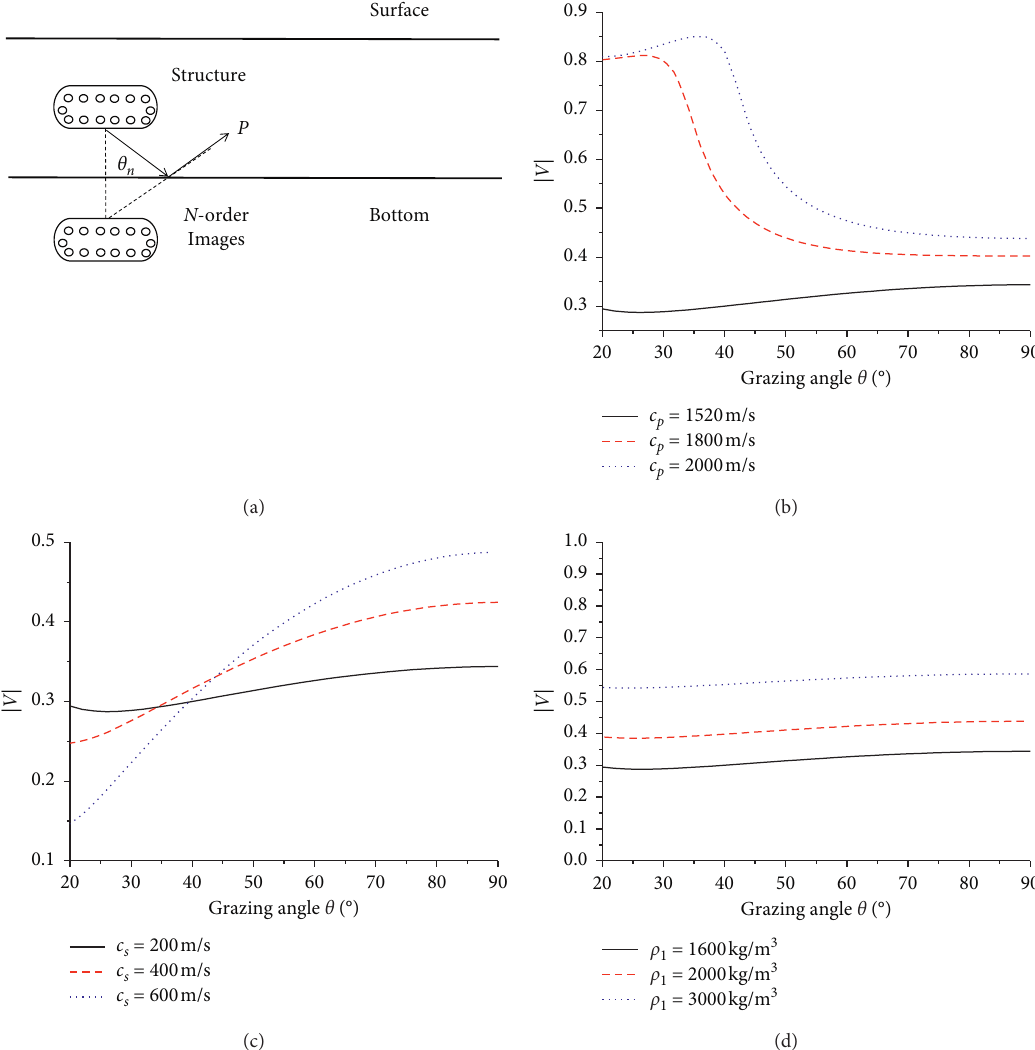
Figure 4: (a) The illustration of acoustic radiation with a boundary. (b) The | V | − θ curves with different compression wave speeds � 1600kg/m 3 ). (c) The | V | − θ curves with different shear wave speeds ( c ( c s � 200m/s , ρ 1